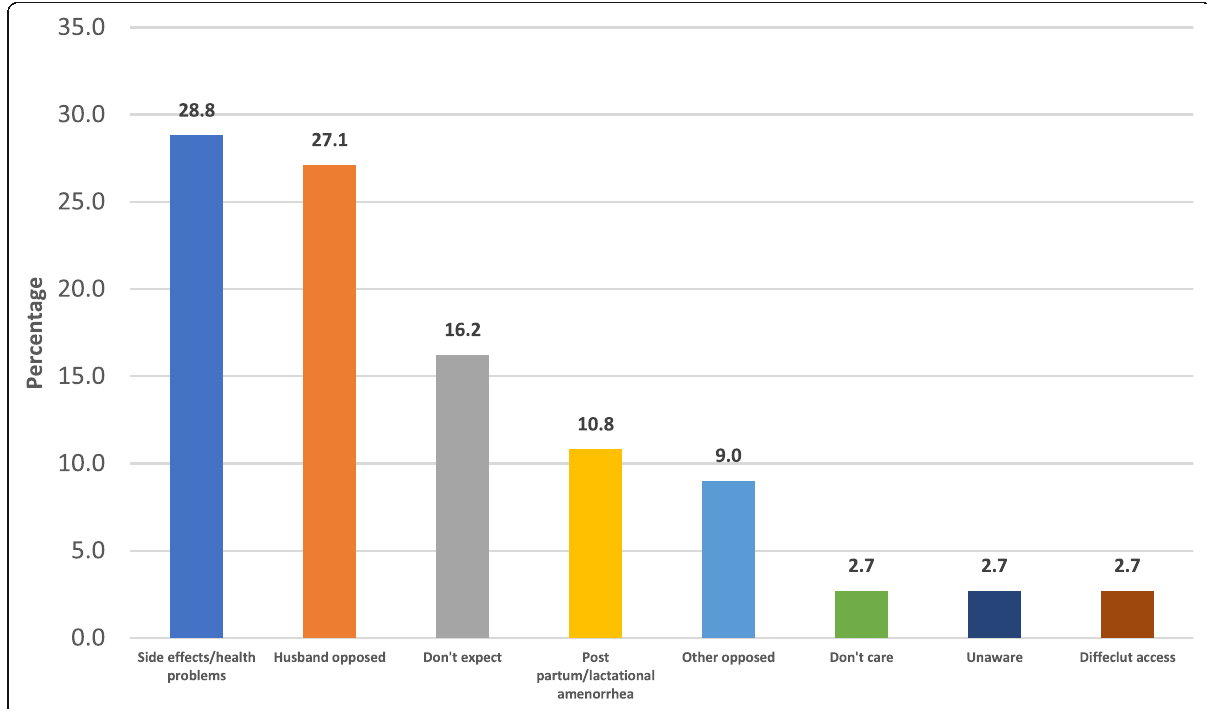
Fig. 3 Causes of non-use of contraceptive methods among women with unintended pregnancy, Sohag district,